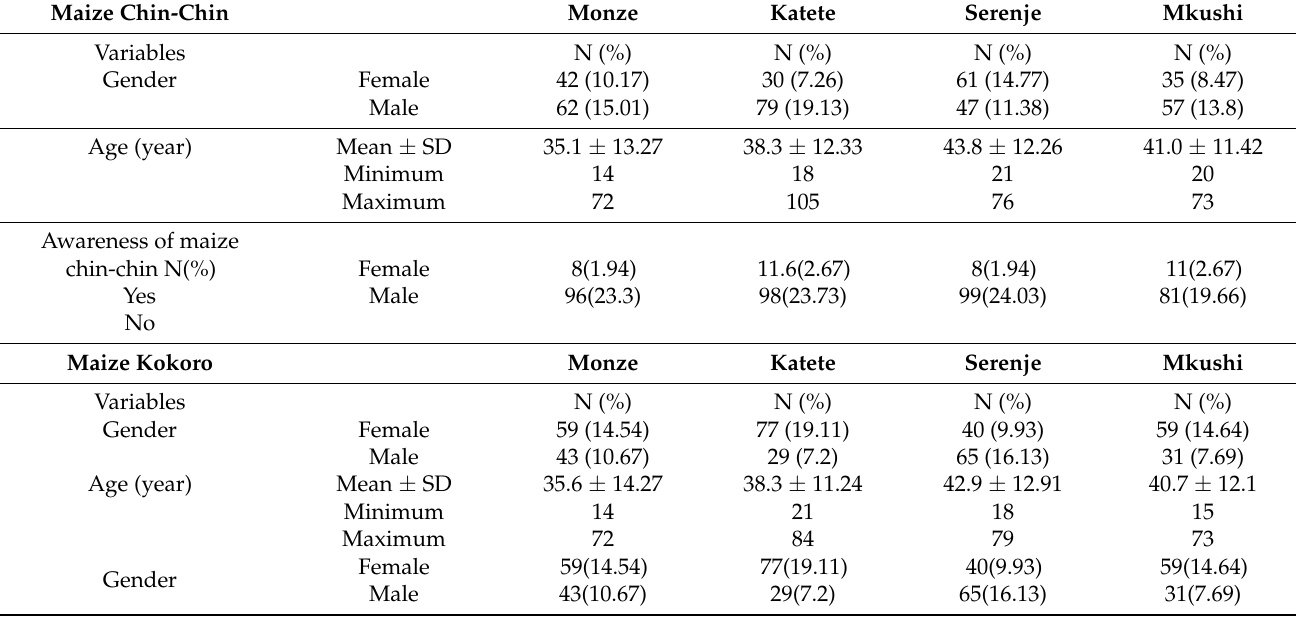
Table 4. Demographic information of the respondents for maize-based products. Maize